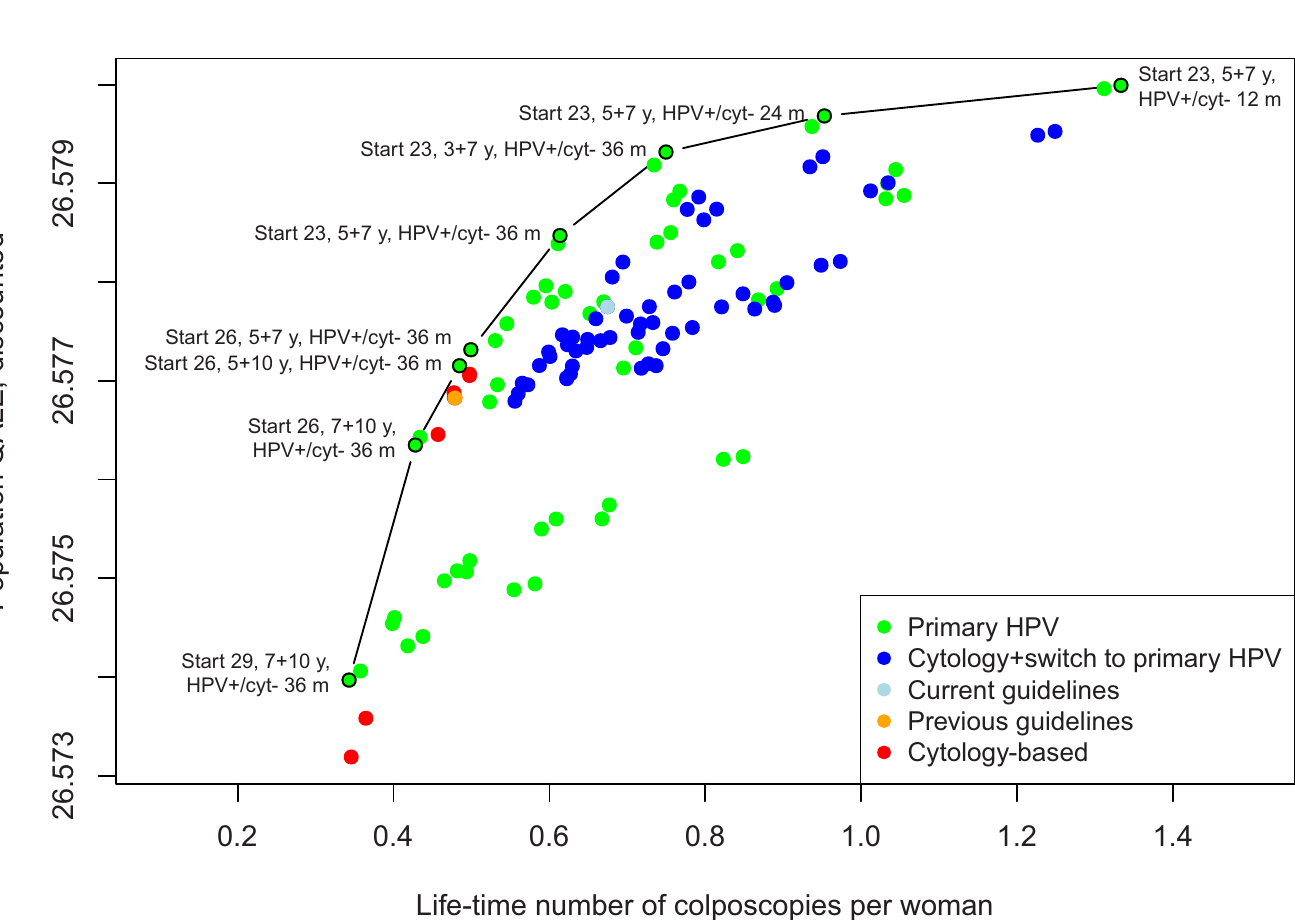
Fig 3. Discounted (3%) quality-adjusted life expectancy and lifetime number of colposcopy referrals per woman for the 116 screening strategies under the base case assumptions, including the eight strategies on the colposcopy referral per QALY gained frontier. The no screening strategy (natural history) has been excluded from the graph. Strategy nomenclature: Start indicates start age, y indicates years (before and after age switch) and HPV+/cyt- m indicates the follow-up time for HPV- positive, cytology negative women (in months).